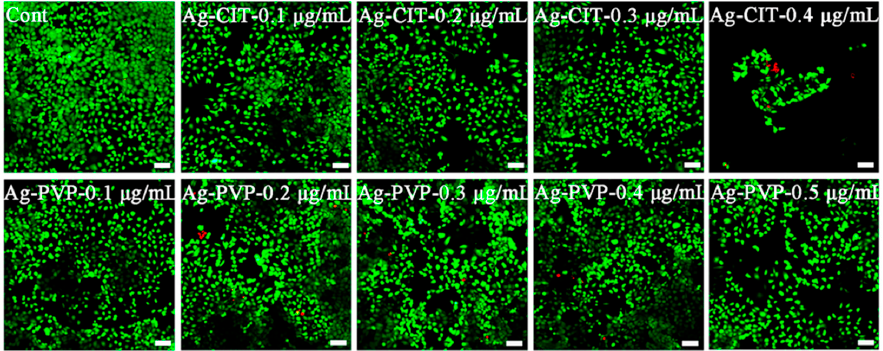
Figure 10. The representative live/dead staining images of Caco-2 cells after exposed to Ag-CIT and Ag-PVP in different concentrations for 21 days. The positive control was prepared by treating normal cells with 200 mM H 2 O 2 for 10 min. Scale bar: 60 μ m.